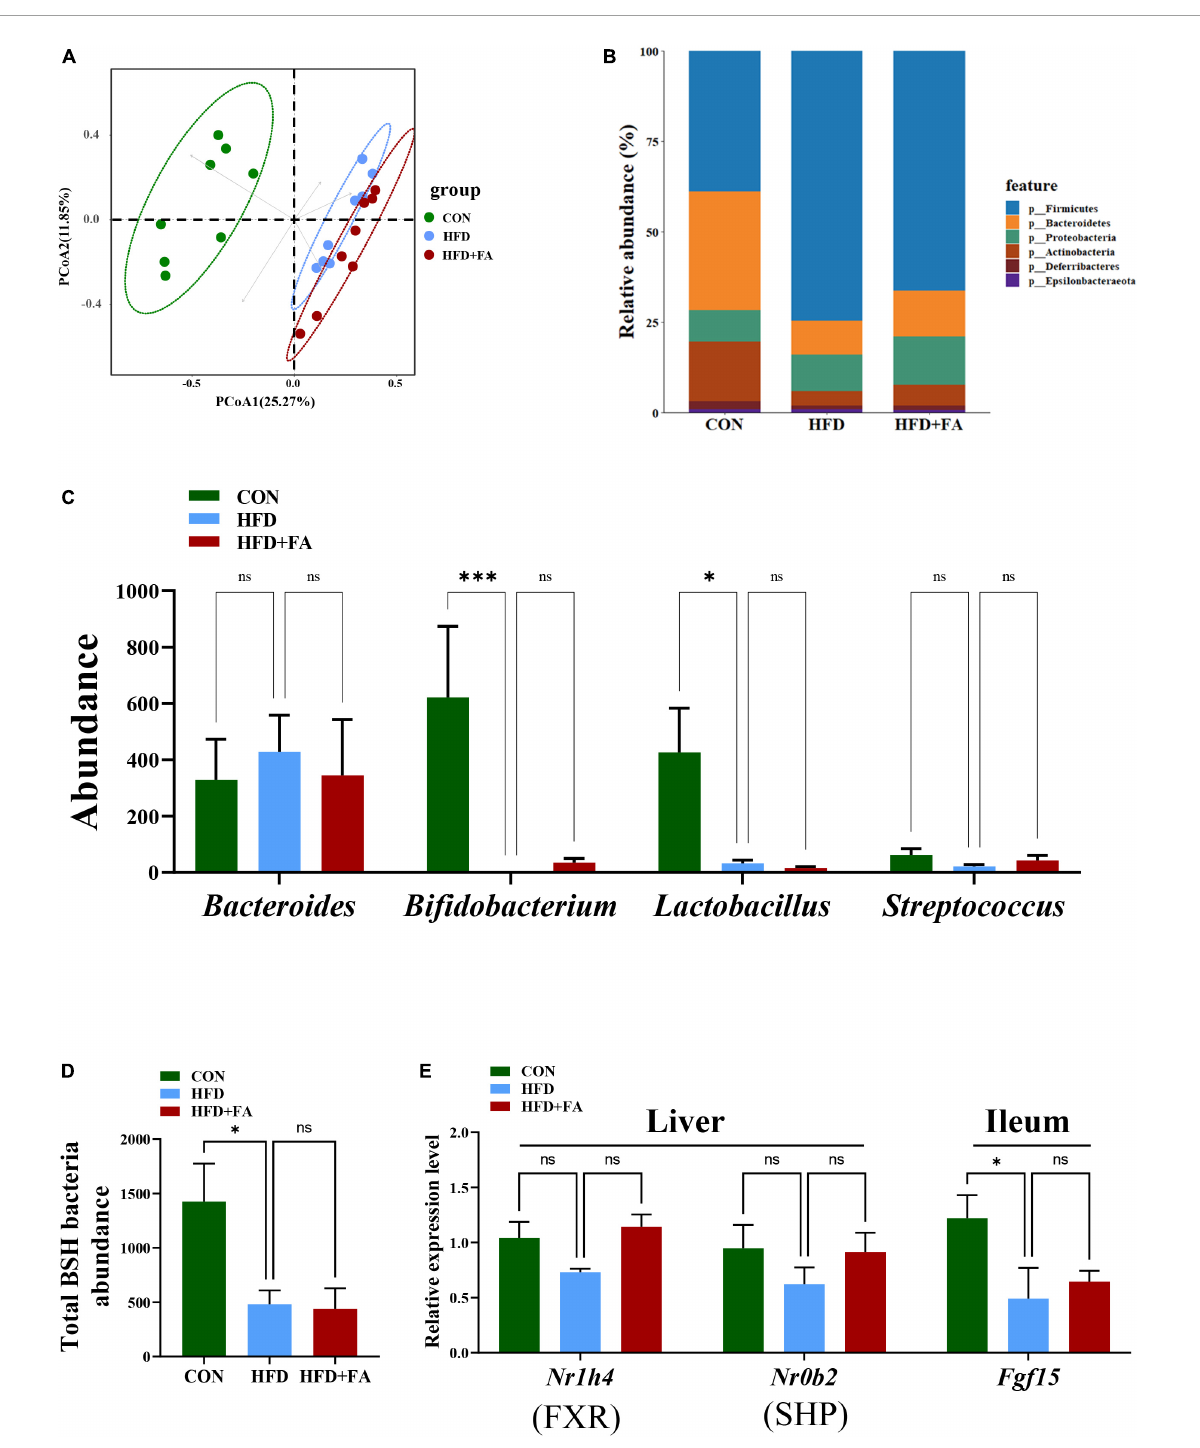
FIGURE5 Enterohepatic FXR signaling is not involved in the activation of hepatic CYP7A1 by FA. (A) PCoA analysis of fecal microbiome based on unweighted UniFrac metrics at the operational taxonomic unit (OTU) level for all samples from the CON, HFD and HFD + FA mice ( n = 8). (B) Relative abundances at phylum level. (C) The abundance of BSH-enriched bacterial genera including Bacteroides, Bifidobacterium, Lactobacillus, and Streptococcus in feces from the CON, HFD and HFD + FA mice ( n = 8). (D) Abundance of total BSH enriched bacteria in feces from the CON, HFD, and HFD + FA mice ( n = 8). (E) The mRNA level of FXR and SHP in the liver and Fgf15 in the ileum ( n = 6). Data are presented as means ± SEM. ∗ p < 0.05, ∗∗∗ p < 0.001, ns, no significance vs. HFD group. CON, control diet group; HFD, high-fat diet group; HFD + FA, high-fat diet with 100 mg/kg bw/day FA